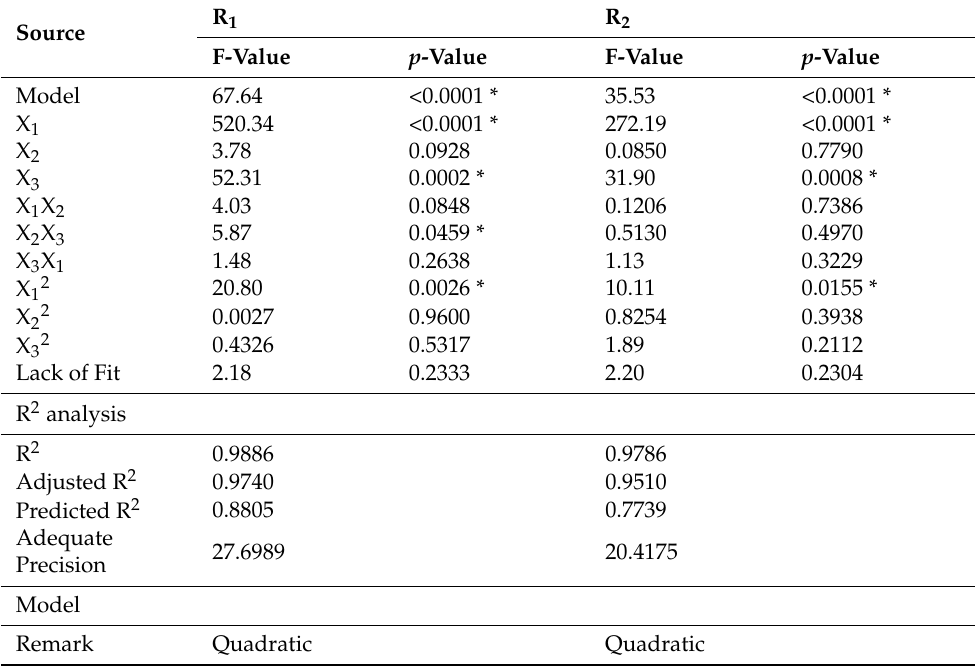
Table 2. Results of statistical analysis results for all